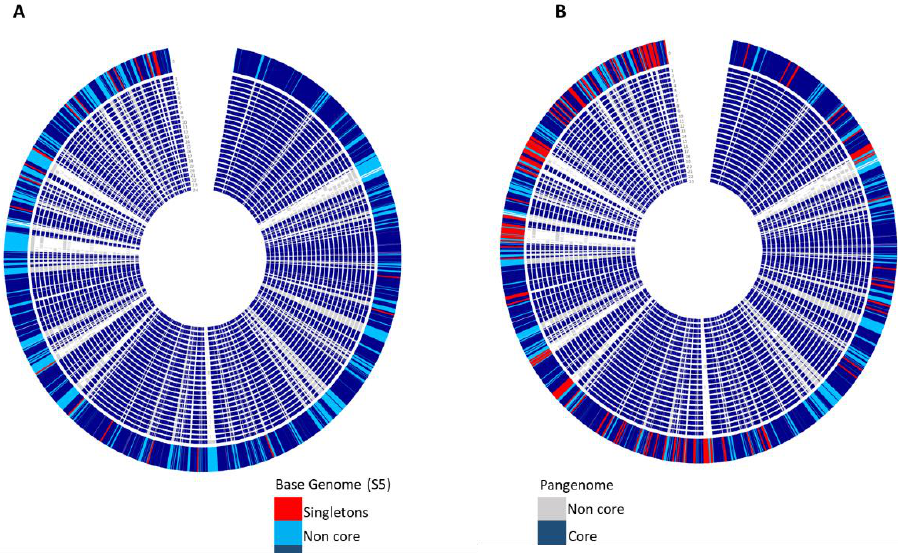
Figure 4. Pan-genome circular visualization output. ( A ) Isolates S4 and S5 compared to representa- tives of all validly published Enterobacter species (see Materials and Methods for full species list and accession numbers); each red strip indicates a gene that is unique to the isolate S5, which was used as a base genome. ( B ) Isolate S5 compared to validly published Enterobacter species; each red strip indicates a gene that is unique to the isolate S5. ( B ) Isolate S4 is not included in the analysis as it is highly identical to isolate S5 and would mask the true variation in the isolates compared to other Enterobacter species.